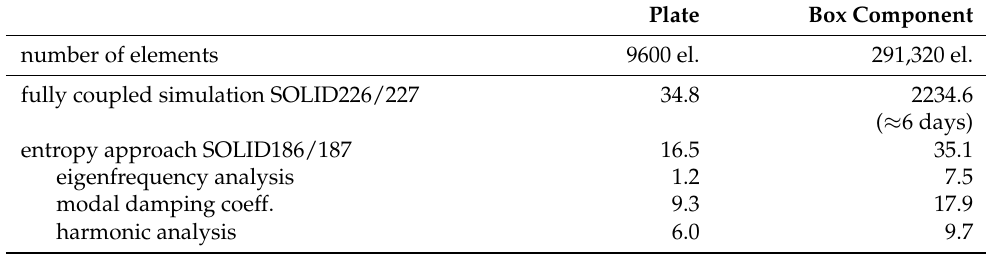
Table 2. Computing time in CPU hours for a frequency–domain analysis using a direct solution procedure with fully coupled thermoelastic elements and a mode superposition solution procedure with modal damping. The modal damping coefficients were determined with the entropy approach provided in the paper. For the rectangular plate, 5000 frequency steps were analyzed and, for the box component, 2700 frequency steps were analyzed. All simulations (except for the calculation of the modal damping coefficients) were run on 16 cores of a compute node with 2 Intel Xeon Processor E5-2650 v4 CPUs with a base clock of 2.2GHz and 128GB